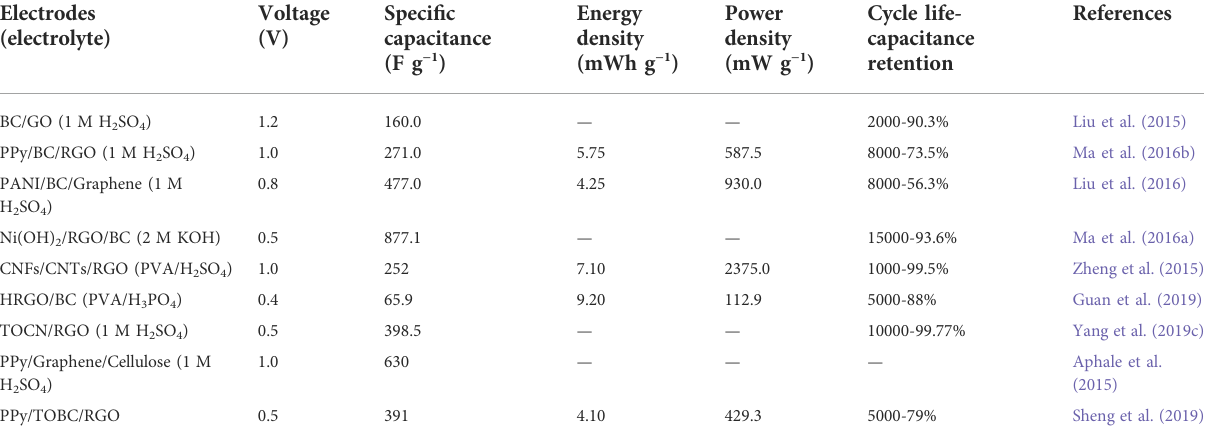
TABLE 2 Electrochemical performance of the nanocellulose/graphene-based supercapacitors. Electrodes